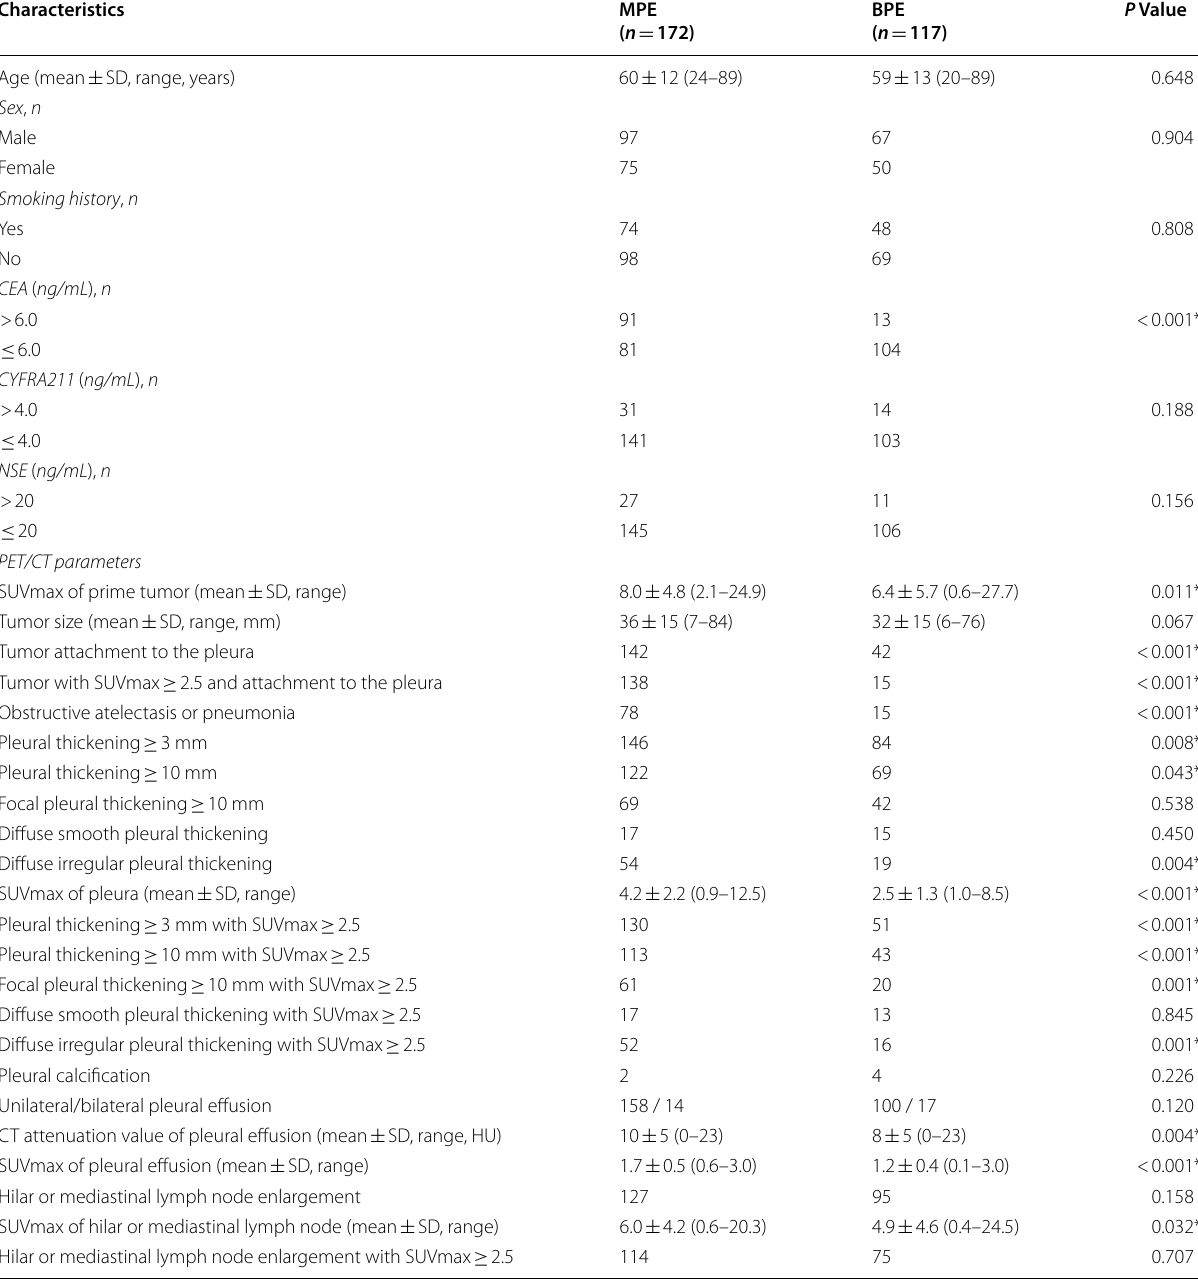
Table 1 Clinical and 18 F-FDG PET/CT characteristics in the training